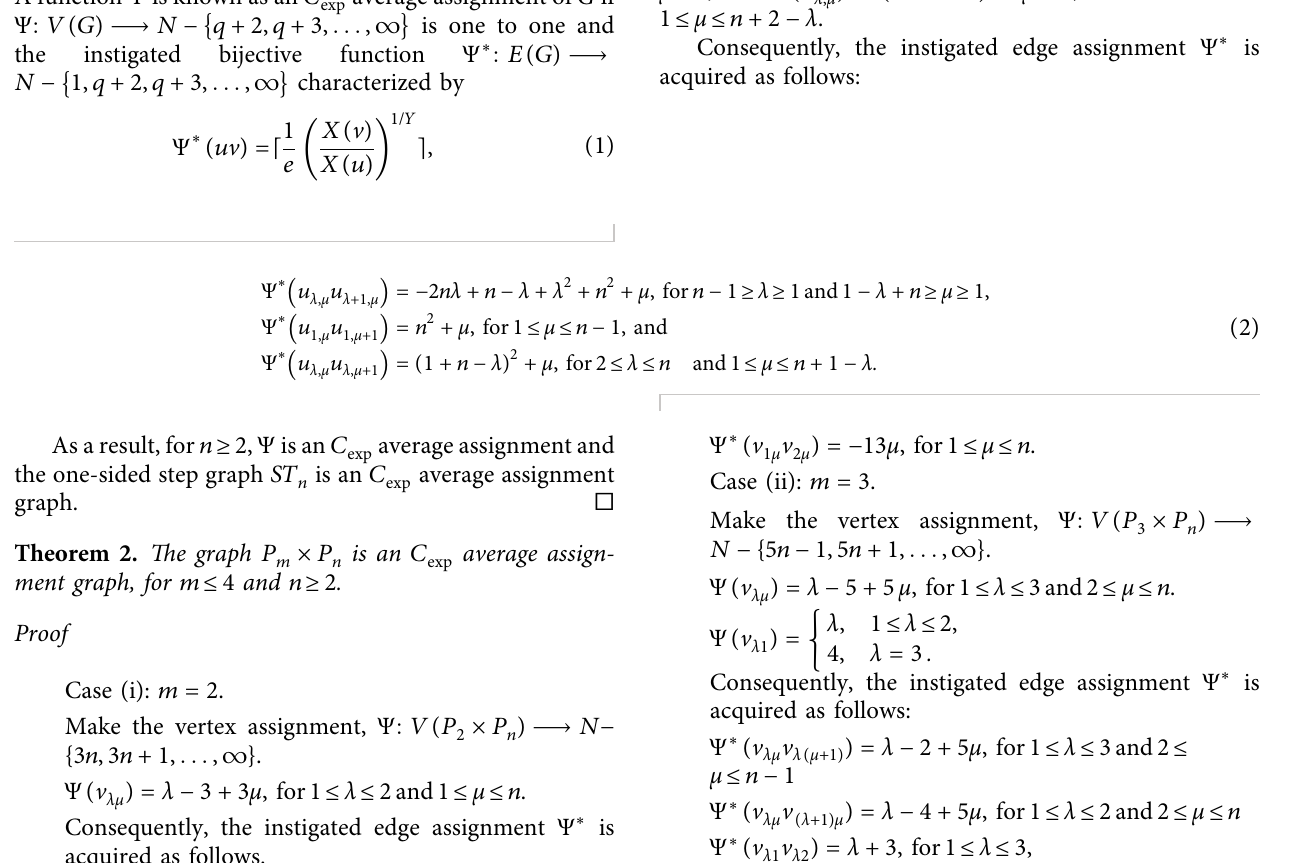
average assignment of the graph, SL exp